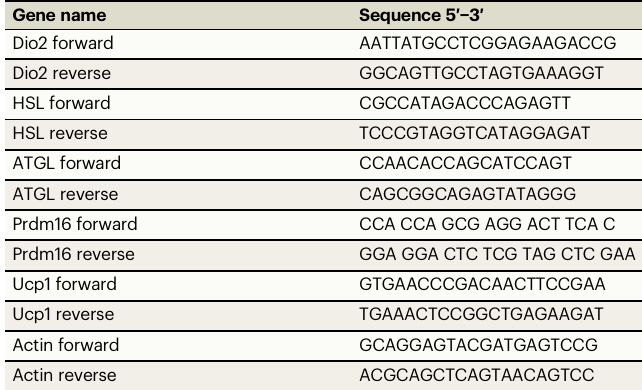
Table 1 | The primer sequences for